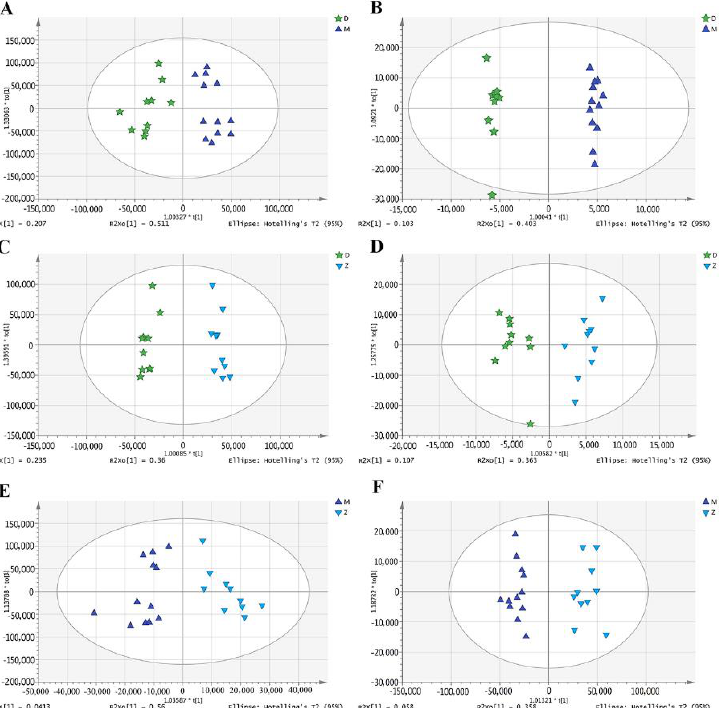
Figure 2. The orthogonal partial least squares discriminate analysis (OPLS-DA) of metabolomic data in both positive ( A , C , E ) and negative ( B , D , F ) ionization modes. D indicates milk samples from Mediterranean buffalo; M indicates milk samples from Murrah buffalo; Z indicates milk samples from crossbred buffalo.